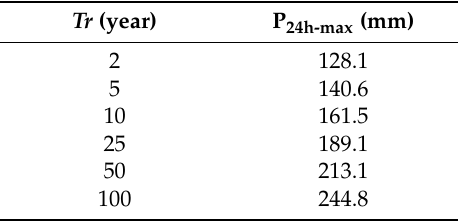
Table 5. P 24h-max values for non-stationary freq. analysis.